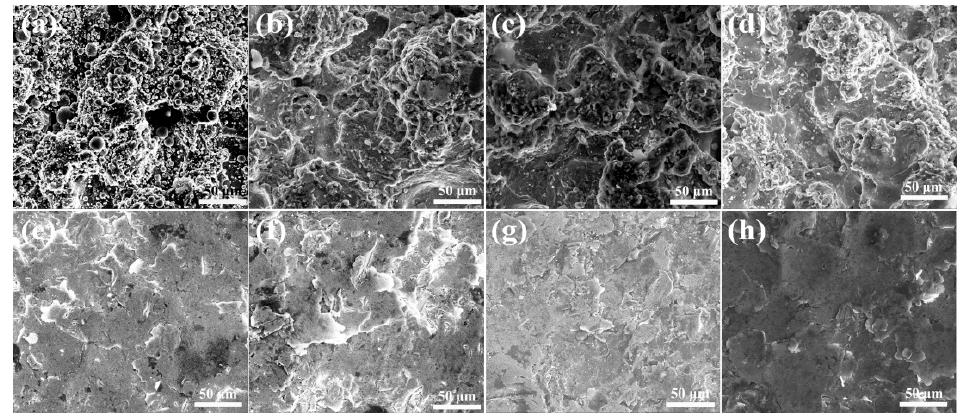
Figure 2. Surface morphology of FeCoNiCrMo 0.2 high entropy alloy coating on BS960 high strength uh. steel ( a ) 250 A, ( b ) 350 A, ( c ) 450 A, ( d ) 550 A, ( e ) 250 A + shot peening, ( f ) 350 A + shot peening, ( g ) 450 A + shot peening, ( h ) 550 A + shot